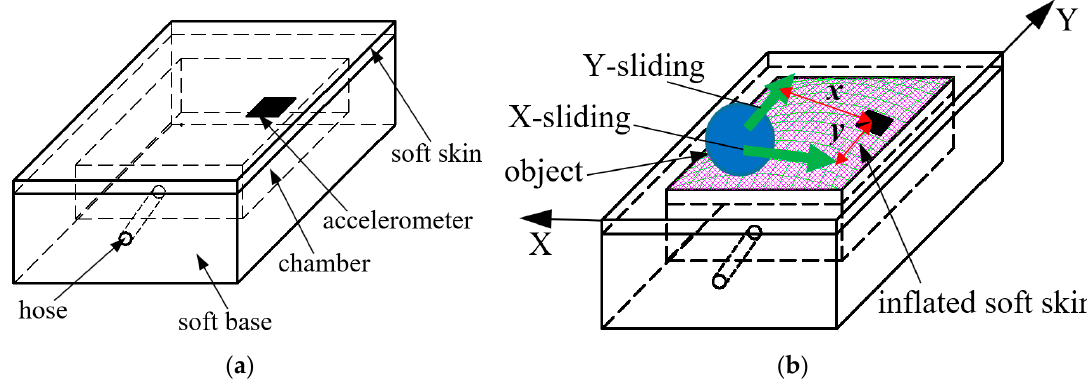
Figure 1. Schematic drawing of soft tactile sensing system: One soft skin layer with embedded accelerometer covers another soft base. In this base, a chamber is cut from its surface and has a hose for input compressed air. Under pressurization inside it, soft skin is inflated, changing the accelerometer’s posture. When object slides on inflated soft skin, accelerometer is sensitive to deformation at contact positions. ( a ) Initial state: without pressurization, soft skin is flat. ( b ) With pressurization, soft skin is inflated, making sensitivity of soft tactile system to sliding action on its surface.